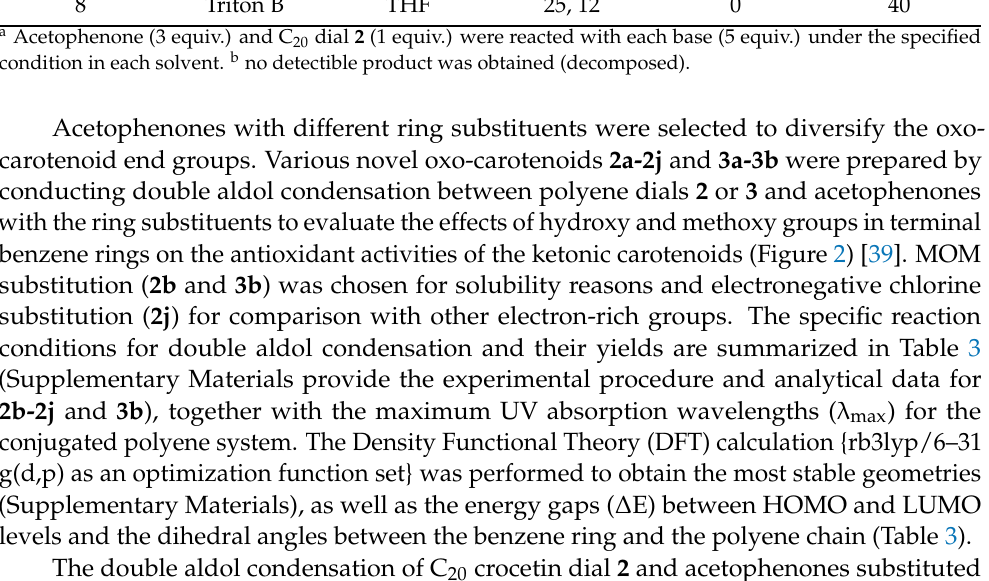
Table 2. Optimization Study for Aldol Condensation between C 20 dial 2 and acetophenone—Product yields of 2a-al (mono-coupling) and 2a (di-coupling). Condition 2a-al (%) 2a (%) Entry a Base Solvent ( ◦ C, h) 1 NaOH aq . MeOH 25, 12 0 0 2 LiOMe MeOH 25, 12 48 0 NaOH MeOH 70, 12 NaHMDS THF − 78, 2 Triton B MeOH 25, 12 0 Triton B MeOH 70, 5 - - Triton